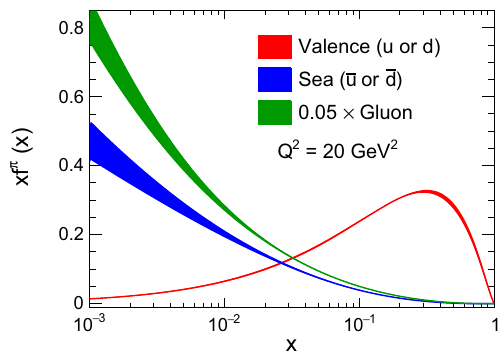
Fig. 7 The valence quark, sea quark and gluon distributions of the kaon from this work. The error bands show the 3 σ uncertainties of the quantities With the obtained PDFs of pion and kaon at high Q 2 , we per- formed the fits to them and extracted the corresponding pow- ers α , which are listed in Table 3. The exponents α are around 0.5 for the valence quark distributions; The exponent α is around1for thestrangevalencequarkdistribution;